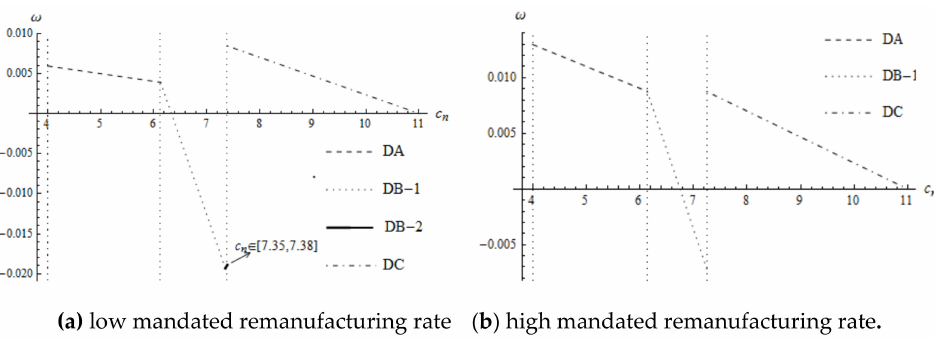
Figure 1. The impact of c n on the supplier’s product design decision.